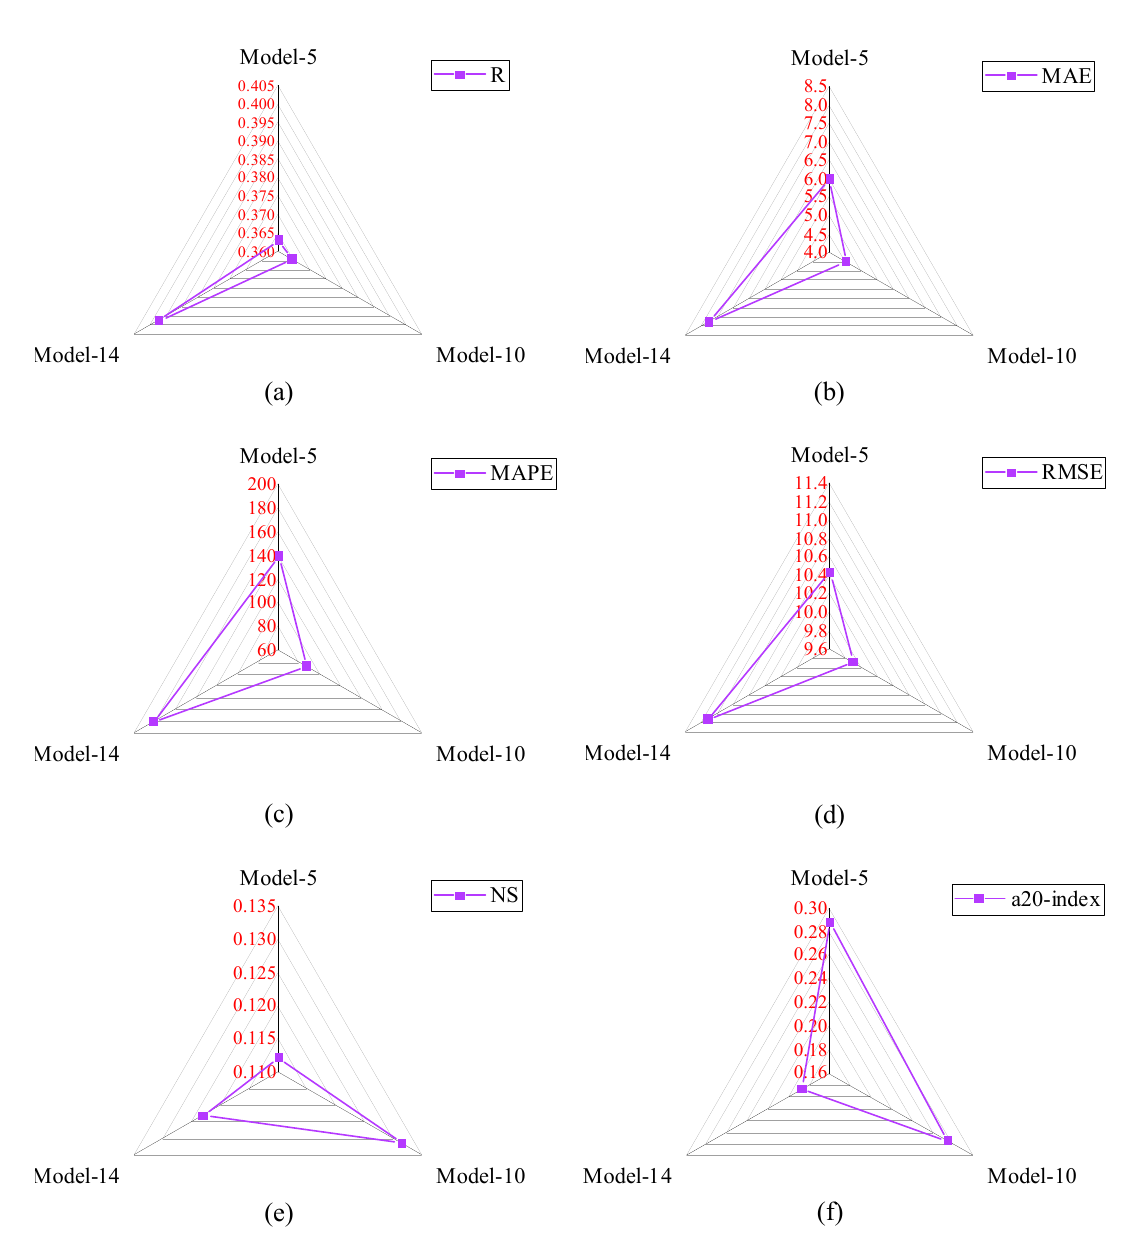
Figure 9. Comparison of performance indices of Group-III models; ( a ) R, ( b ) MAE, ( c ) MAPE, ( d ) RMSE, ( e ) NS, ( f ) a-20 index. Figure 10 indicates the relationship between experimental and predicted values for each of the analytical models. In all the cases, the scatter plots show the poor performance of all the analytical models.